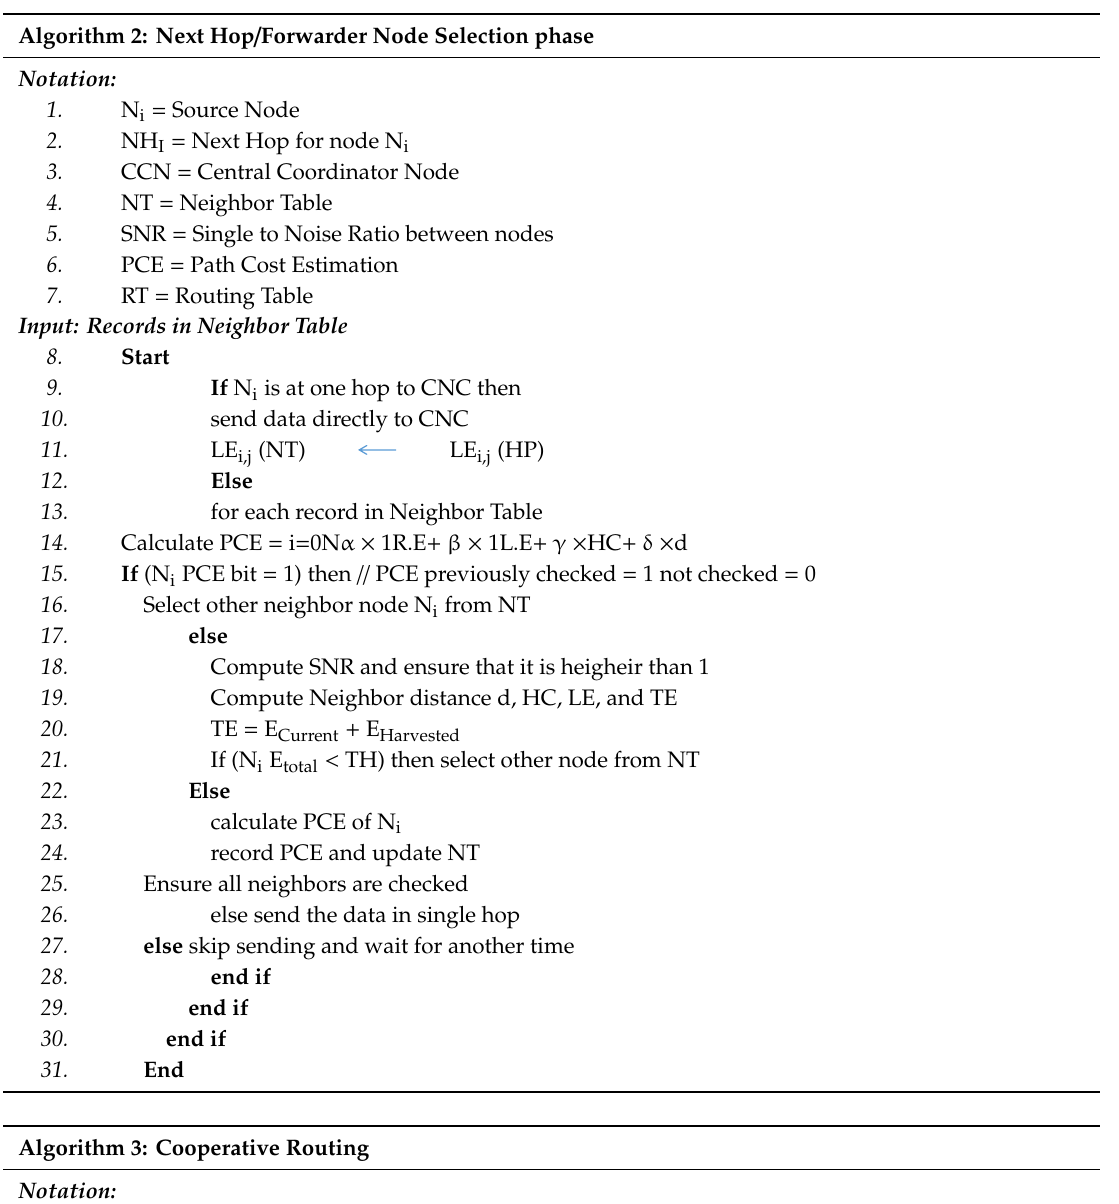
Algorithm 2: Next Hop / Forwarder Node Selection phase